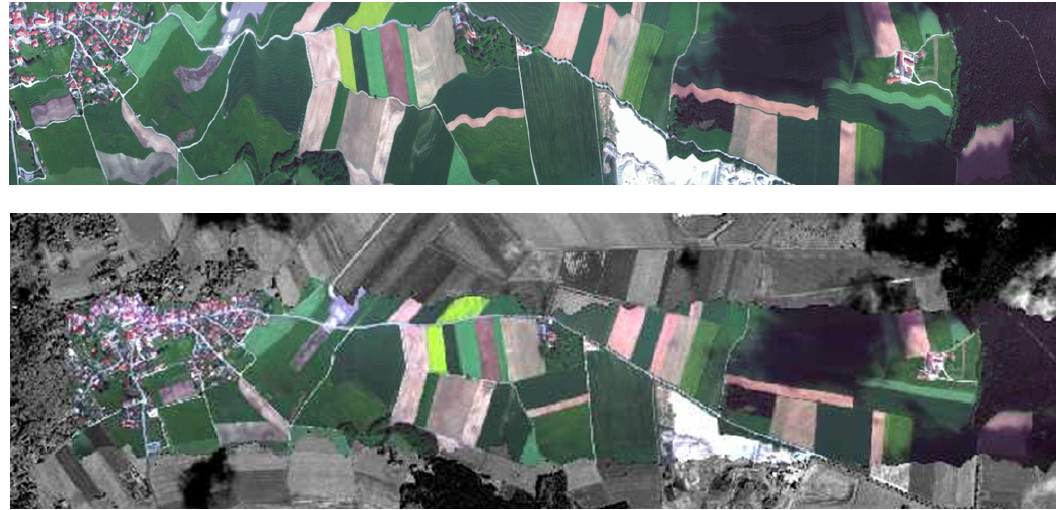
Figure 11. Original (top) and geometrically corrected AVIS-2 data using dGPS/INS attitude information (bottom, overlay with georeferenced IKONOS image).